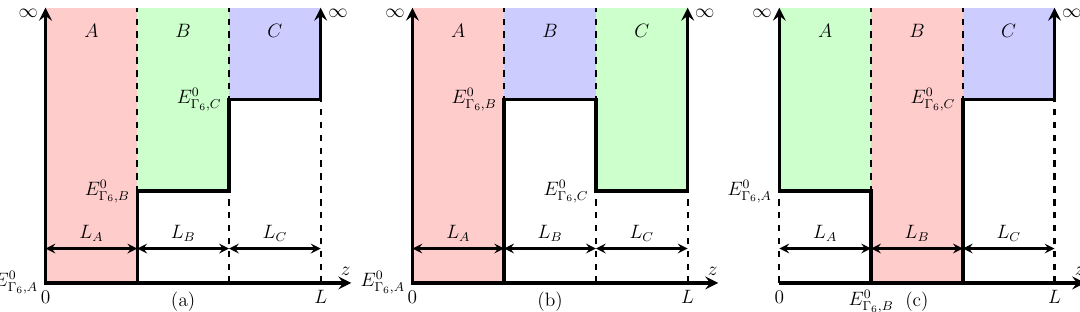
Figure 1. Three types of three-layer semiconductor nanoplatelets made of materials A , B , and C with different electron affinities χ A , χ B , and χ C : ( a ) χ A > χ B > χ C , ( b ) χ A > χ C > χ B , and ( c ) χ B > χ A > χ C